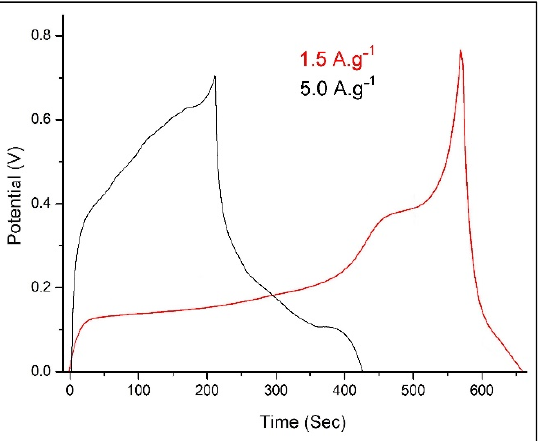
Figure 9. Galvanostatic charge/discharge (GCD) response of PANI@TiO 2 –TiC at different current densities.